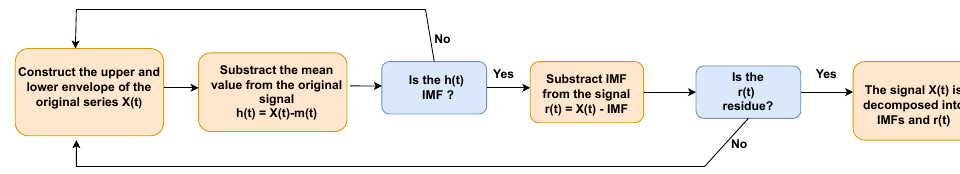
Figure 3. Illustration of the main stages of standard empirical mode